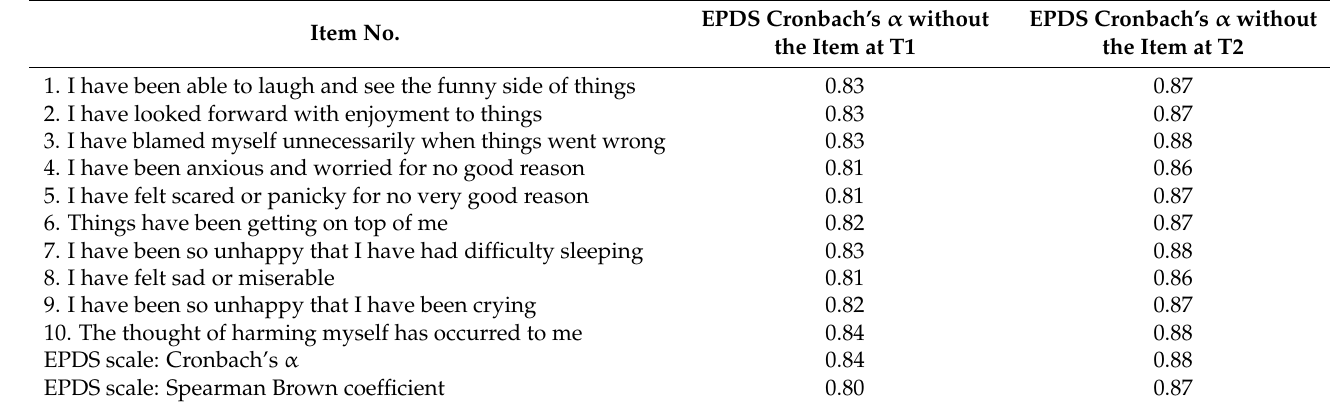
Table 2. Cronbach’s α values for the EPDS items.